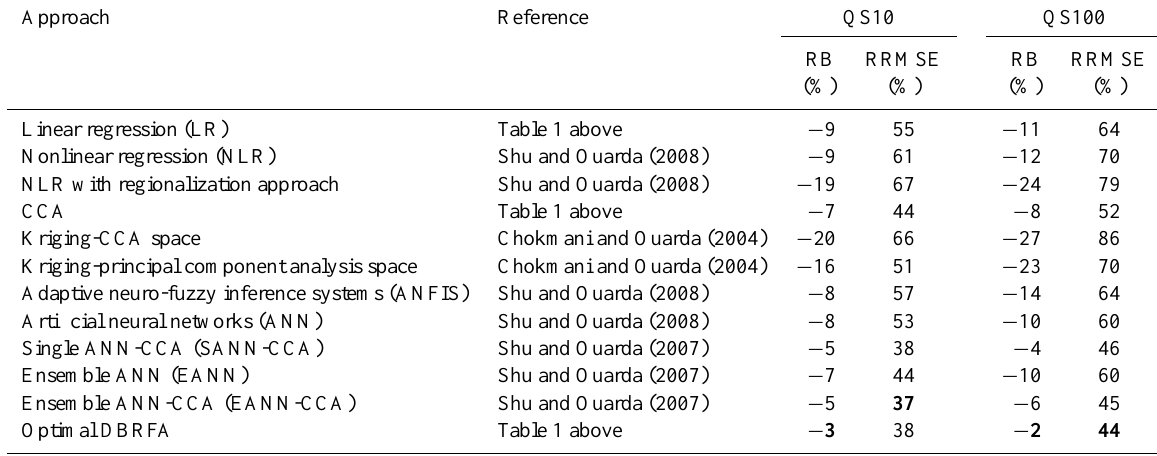
Table 3. Quantile estimation result for Quebec with available approaches and their references.